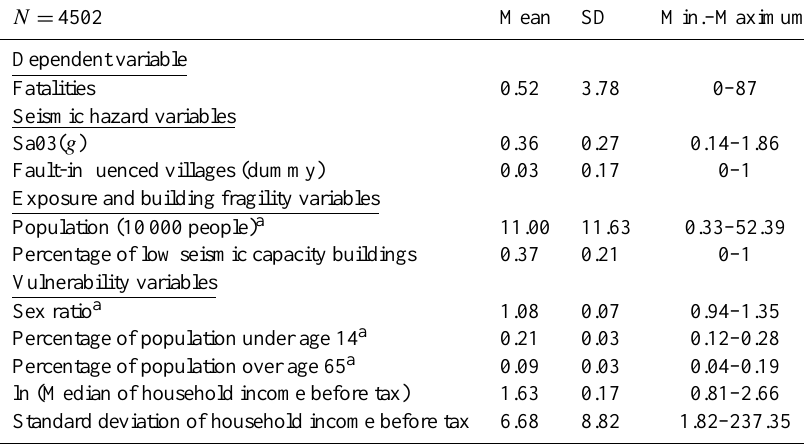
Table 1. Descriptive statistics of selected variables.